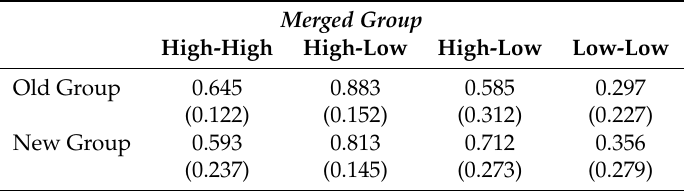
Table A9. Helping: New vs. Old Group members.